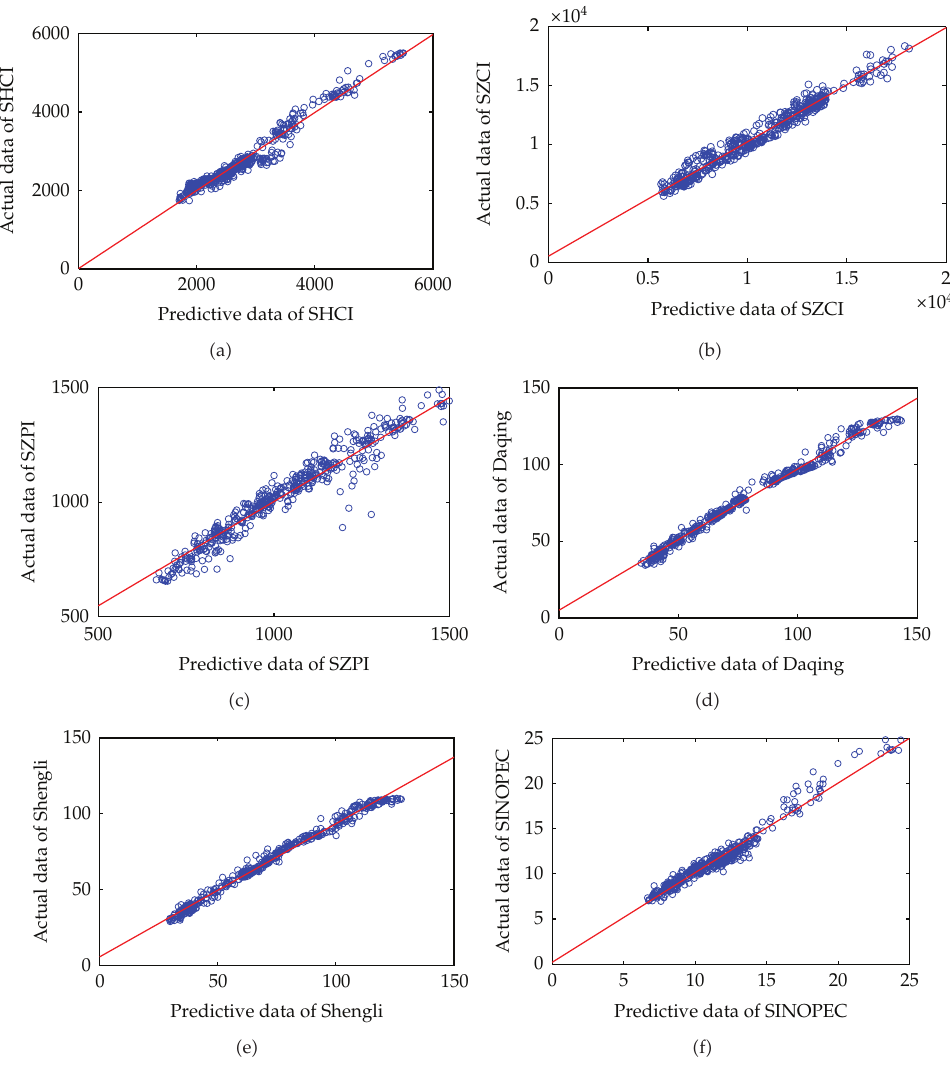
Figure 5: Regressions of the predictive data and the real